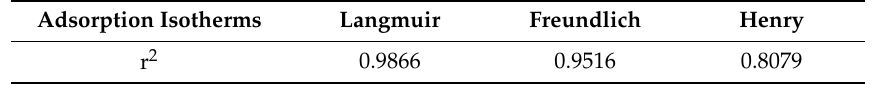
Table 3. Adsorption isotherms applied to the biosorption process.